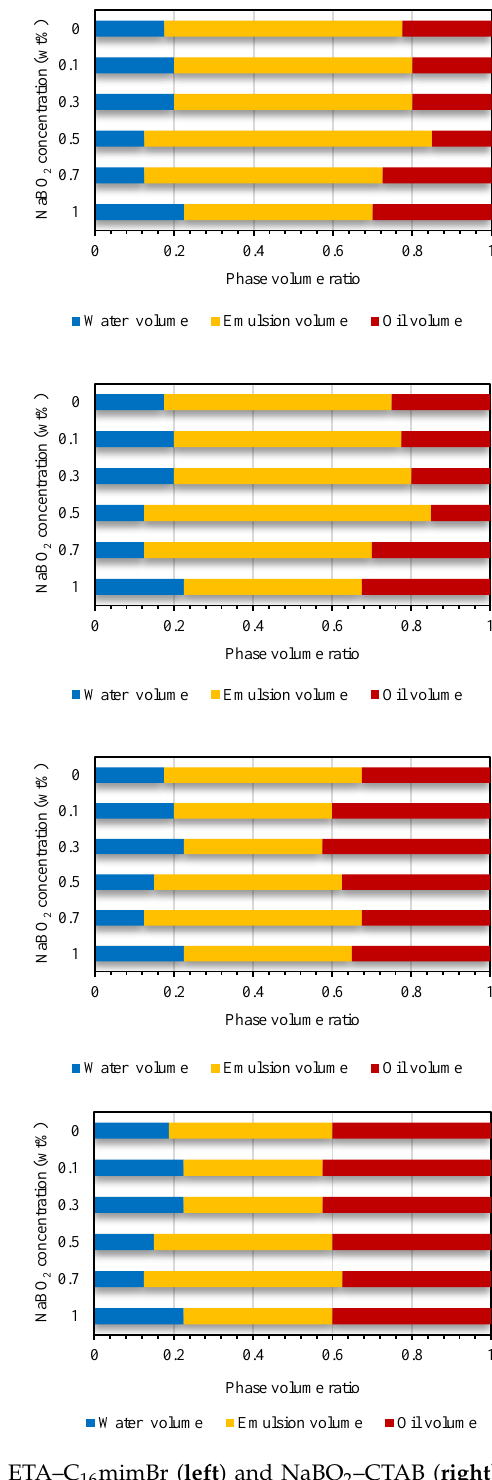
Figure 16. Emulsion stability of the ETA–C 16 mimBr ( left ) and NaBO 2 –CTAB ( right ) systems at various alkali concentrations at 80 °C.